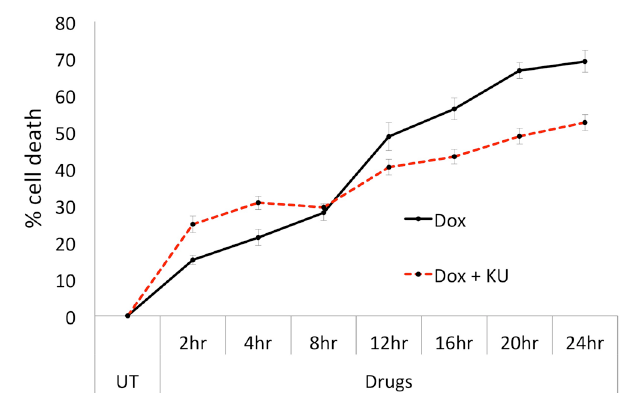
Figure 8. Inhibition of ATM kinase by small molecule inhibitor causes sensitisation during earlier time points while desensitization at later time points of 400nM Dox treatment. HaCat cells were seeded in quadruplicates in 96-well plates and allowed to attach for 24 h. Following this, cells were either left untreated, treated with 400nM Dox or with a combination of 400nM Dox and 10μM KU for the indicated time points and processed for Neutral Red uptake based cytotoxicity assay as described in materials and methods. Readings were taken in 96-well multi plate reader (Modulus template®) by measuring absorbance at 540nm. Values are means of the absorbance acquired from quadruplicate treatments and normalised to the mean value of untreated control (UT) and expressed as % cell death with the formula 100-[(Abs treated sample/Abs untreated sample) x 100]. 540 540 Data is based on n=3 independent